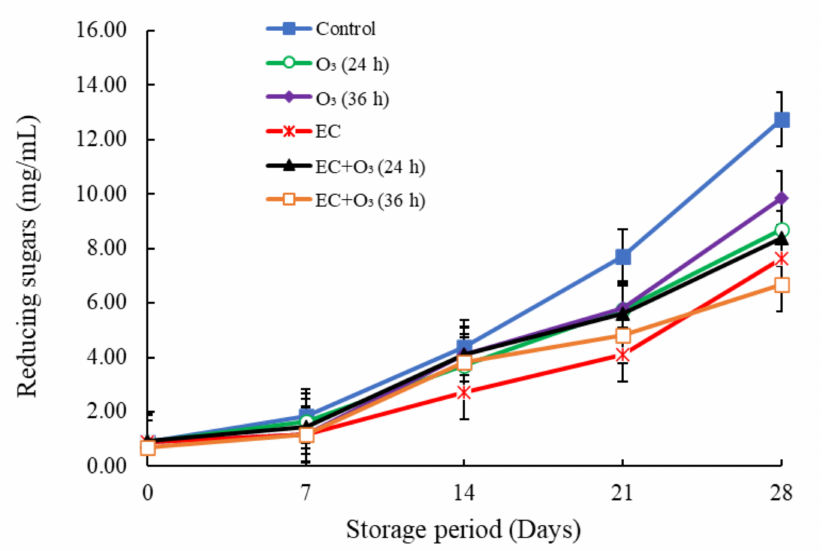
Figure 6. Effect of edible coating (EC) and gaseous ozone (O 3 ) on reducing sugars of mango fruit during storage at 10 ◦ C for twenty-one days and shelf-life at ambient temperature for seven days ( ± SE, n =